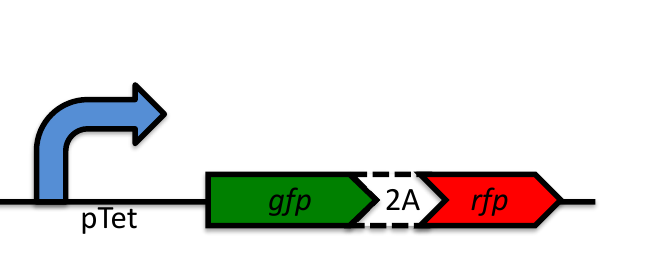
Figure 49: Bicistronic expression of both GFP and RFP from a signal coding sequence, by means of a 2A self-cleaving polypeptide